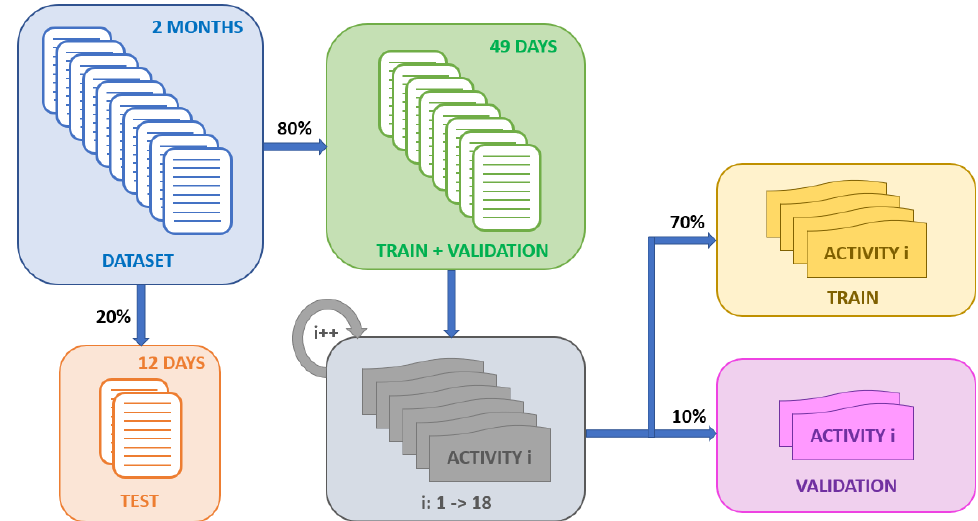
Figure 7. Example of the randomised distribution